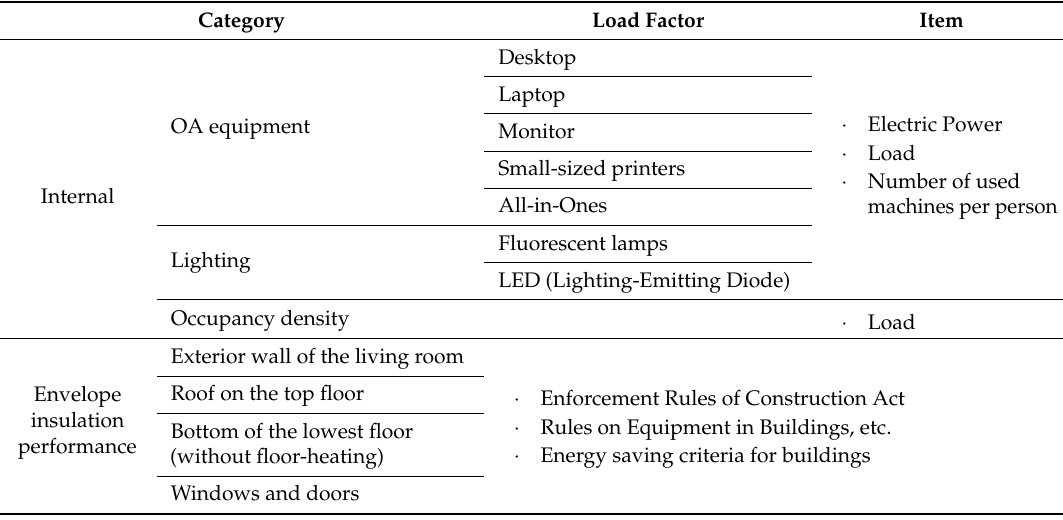
Table 1. Detailed items of literature reviews by load factor.